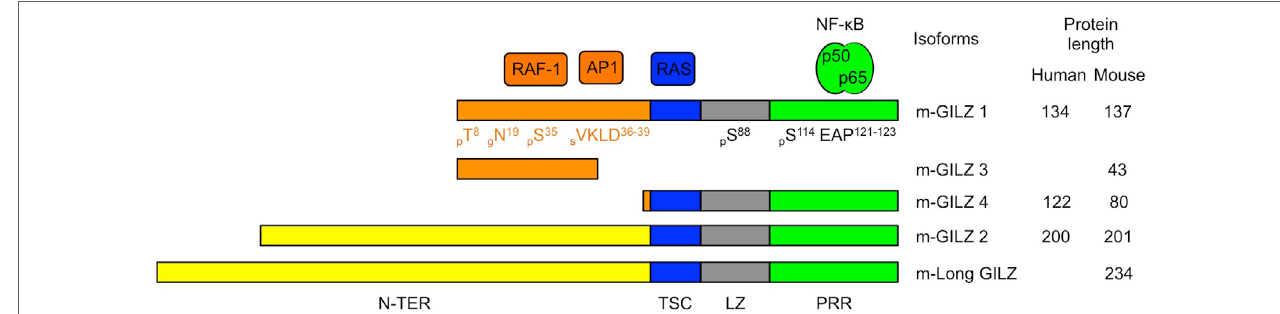
FiGURe 1 | Glucocorticoid-induced leucine zipper (GILZ) isoforms and partners. Five murine GILZ (m-GILZ) isoforms, namely m-GILZ 1–4 and long GILZ (m-Long GILZ) have been identified in mouse (13, 28), with different N-TER domains while m-GILZ1, 2, 4 and m-Long GILZ encompass conserved TSC, LZ, and PRR domains. RAF1 (37) and AP1 (33) interact with GILZ1 and presumably GILZ3 N-TER domain. RAS interacts with the TSC (blue) domain (38). LZ (gray) domain allows dimerization (33). Nuclear factor Kappa B interacts with the PRR (green) domain and requires an EAP motif in positions 121–123 of GILZ1 (39). Predicted posttranslational modification sites are annotated with their positions ( X ) and the nature of the modification, i.e., phosphorylation, p; glycosylation, g; and sumoylation, s. Tsc22-d3 transcription starts either at a canonical AUG codon or at an upstream non-canonical AUG codon. GILZ isoforms derived from the use of the same codon display identical N-TER domain (orange or yellow, respectively). Protein sequences were aligned using BLAST. The scale is proportional to the real size of the protein. N-TER, N-terminal domain; TSC, TGF- β -stimulated clone; LZ, leucine zipper; PRR, proline-rich region.